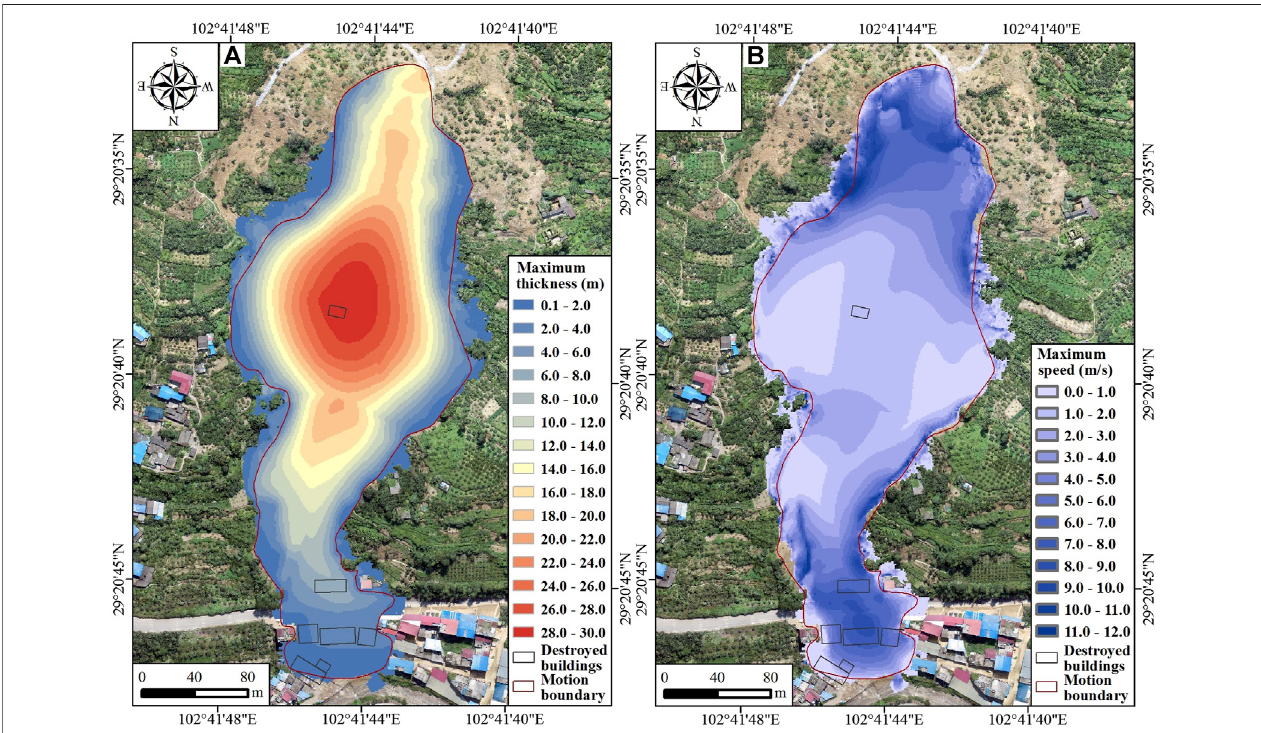
FIGURE 9 | The maximum thickness and speed of the main landslide during the sliding process.